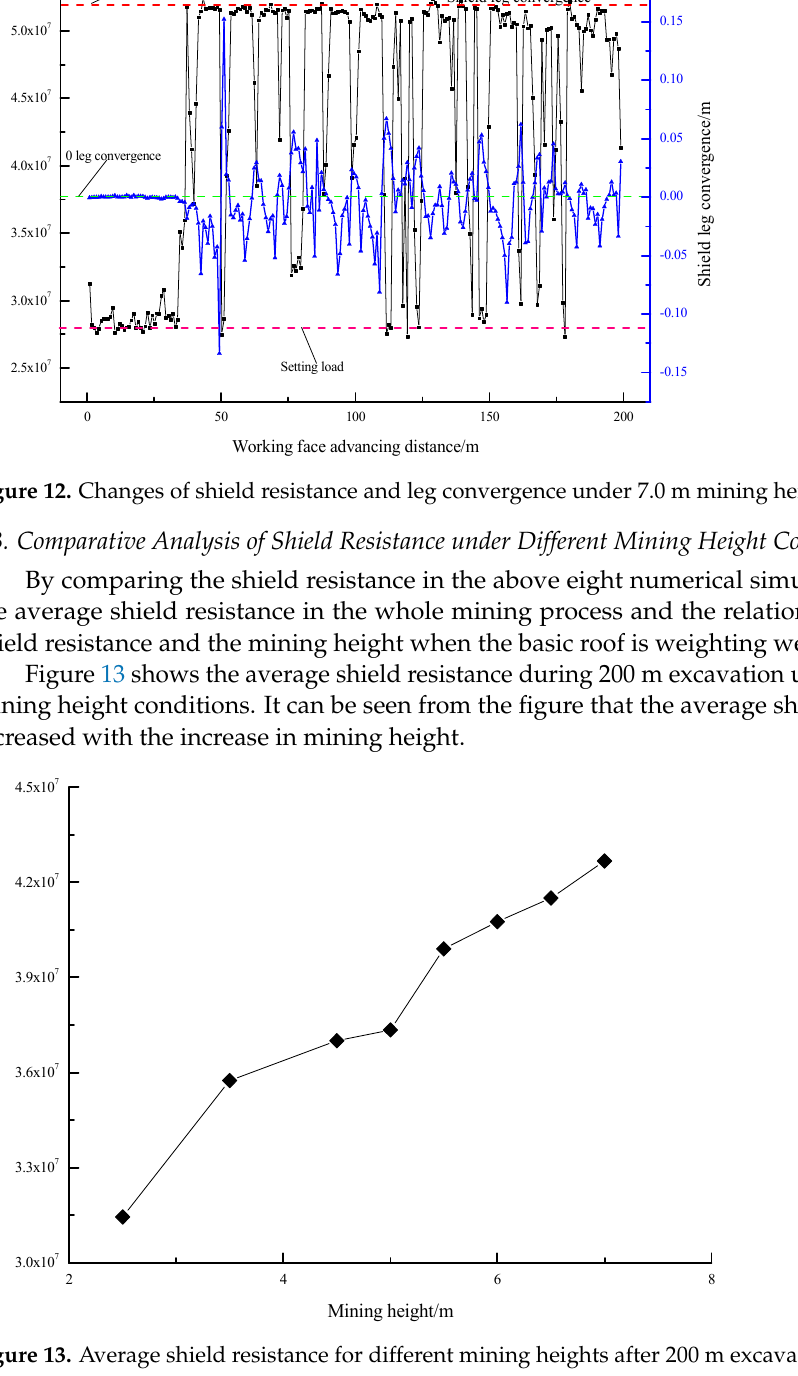
Figure 13. Average shield resistance for different mining heights after 200 m excavation. resistance was relatively large, thus the shield type selection was generally carried out according to the maximum strength of the shield during the basic roof weighting stage, which had a guiding significance for field engineering applications. Figure 14 shows the comparison of the shield resistance at the first and periodic weighting of the basic roof under different mining height conditions. It can be seen from the figure that the resistance of the shield at the first weighting of the basic roof was greater than that of the periodic weighting, but the difference between the two was not significant.